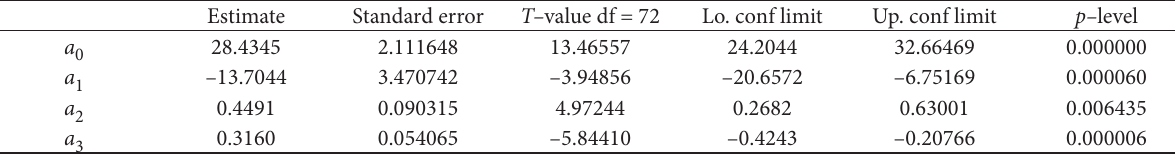
Table 3. Parameter estimates model